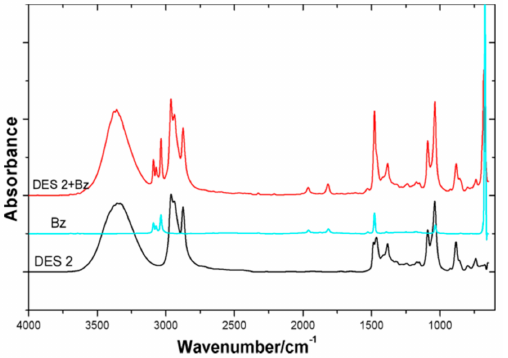
Figure 13. FT-IR spectra of ( a ) DES2 and benzene, ( b ) benzene, ( c ) DES2 (DES2 = 0.1 (molar concen- tration)).